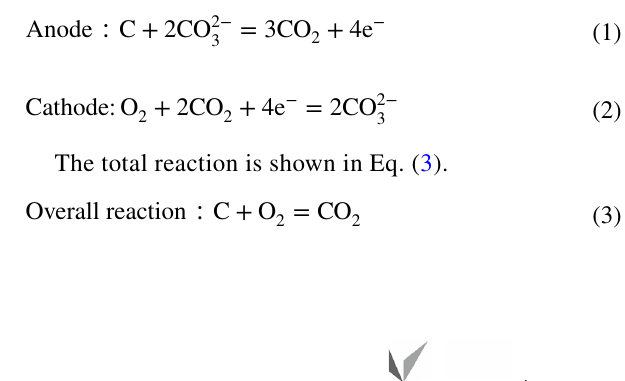
Fig. 2 Different configurations of MC-DCFC: a Unconventional tilted MC-DCFC favoring the continuous supply of fuel that ensures there is no corrosion of the cathode; b Planar MC-DCFC with the mixture of carbon and carbonate located above the anode to ensure low cell resistance; c MC-DCFC with a stirring rod in the molten car- bonate to ensure uniform distribution of carbon particles and improve